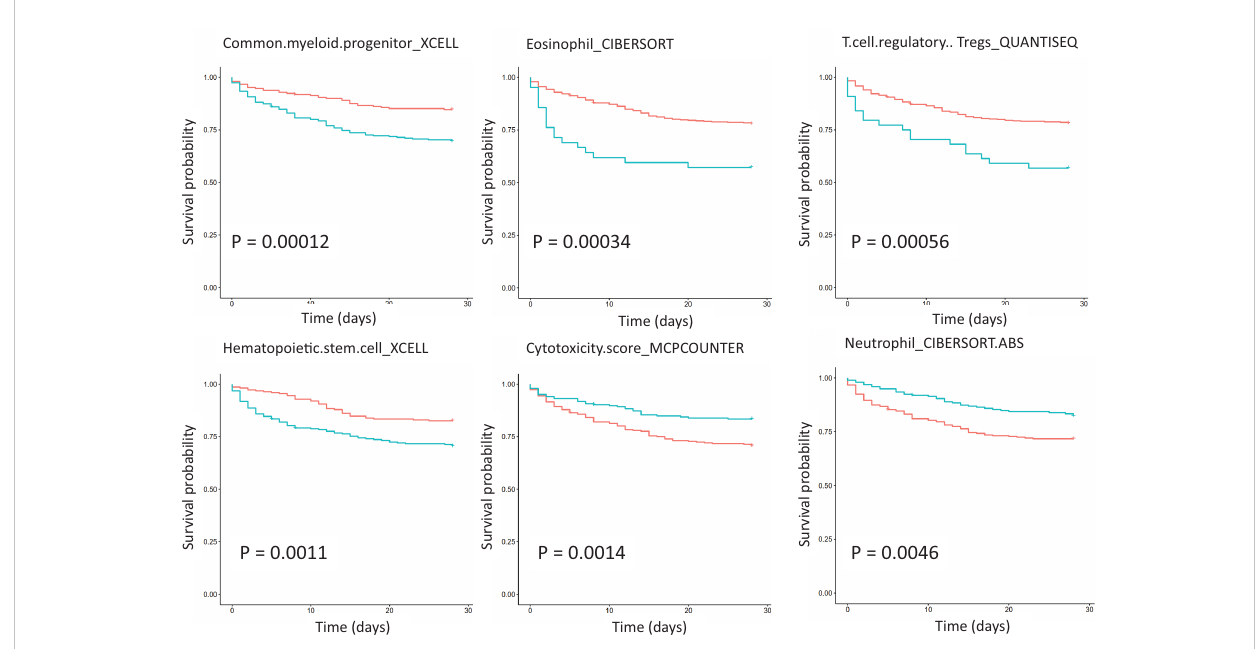
FIGURE 4 Survival analysis of immune cell abundance in critically ill patients with sepsis based on dataset GSE65682, showing the top six immune cell types with the most signi fi cant P values. The red curve represents the low expression of the pathway, the green curve represents the high expression of the pathway, and the P value is obtained according to the log-rank